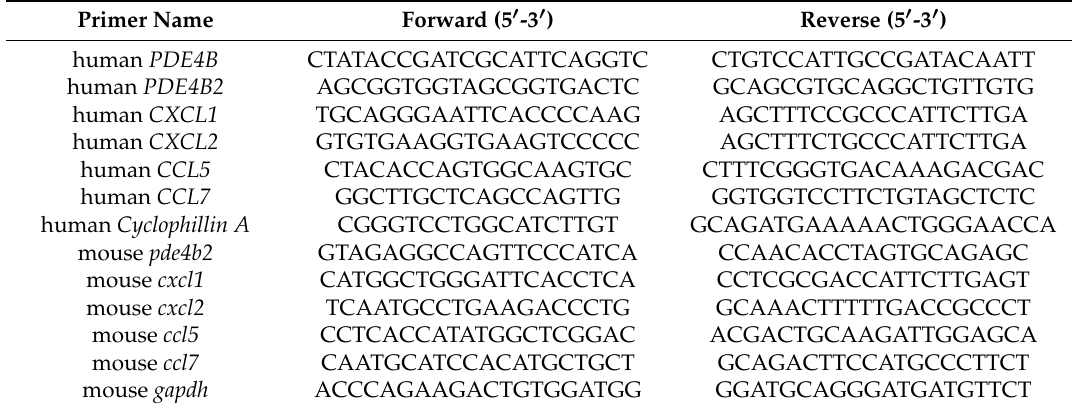
Table 1. Primer sequences for quantitative real-time